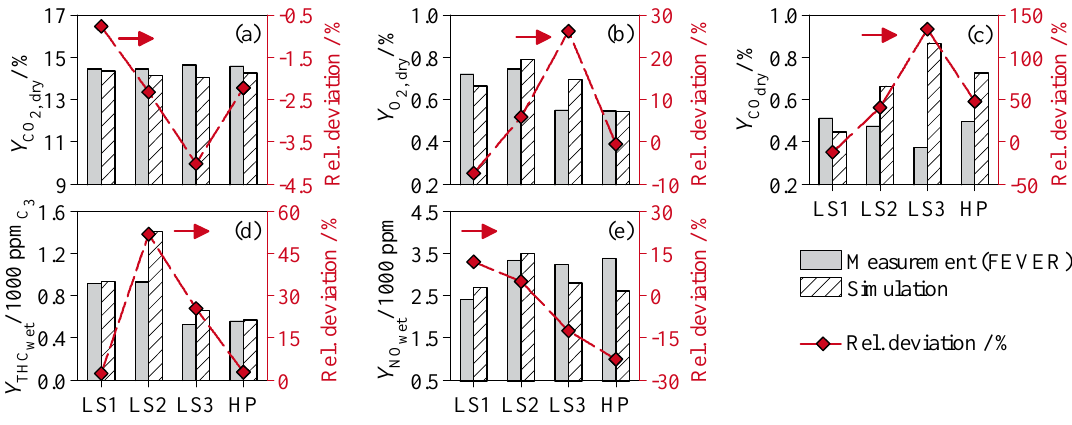
Figure 7. Comparison of average emissions in Pos. 2 between simulation and FEVER measurements (bars, left axis) with relative deviation (line plot, right axis): ( a ) CO 2 , ( b ) O 2 , ( c ) CO, ( d ) THC, and ( e )